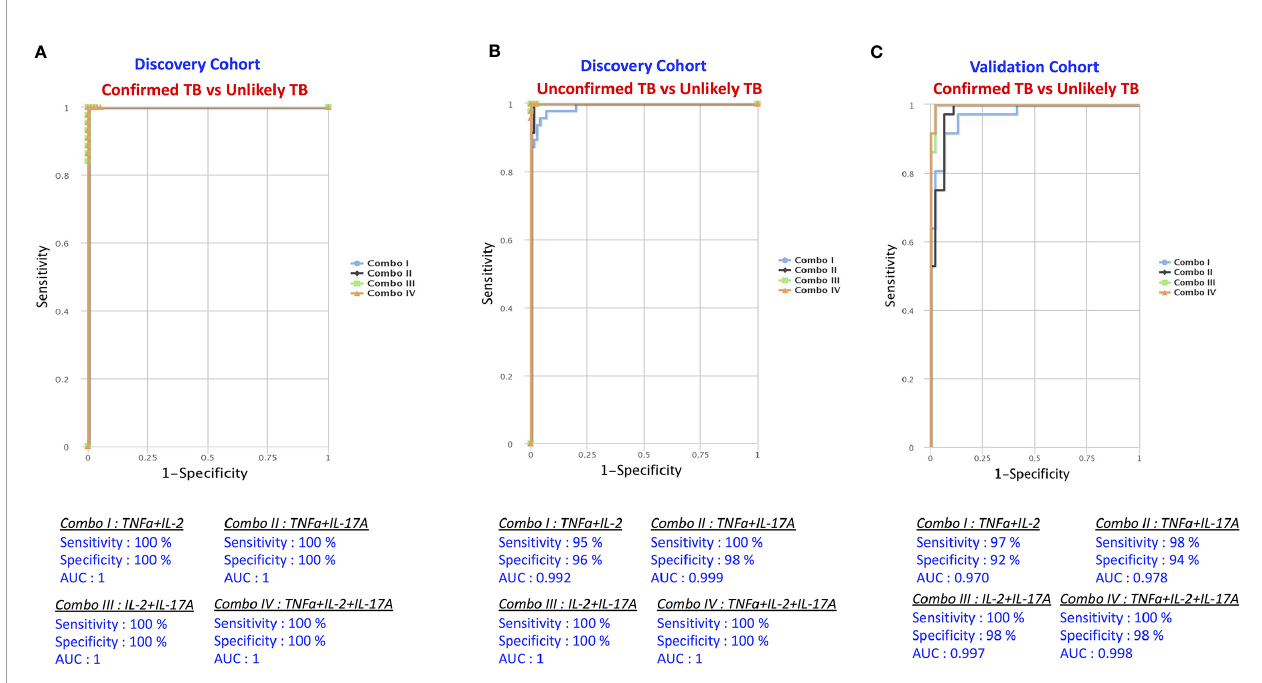
FIGURE 6 | Identi fi cation of biomarkers showing the strongest association using combination of cytokine biomarkers in active TB disease. CombiROC model analysis shows the cytokines that exhibited the highest accuracy in discriminating active TB disease from unlikely TB. ROC curves for comparing multiple markers and their combinations between active TB disease versus controls in the Discovery Cohort (A) Con fi rmed TB vs. unlikely TB, (B) uncon fi rmed TB vs. unlikely TB and in the Validation Cohort (C) con fi rmed TB vs. unlikely TB are